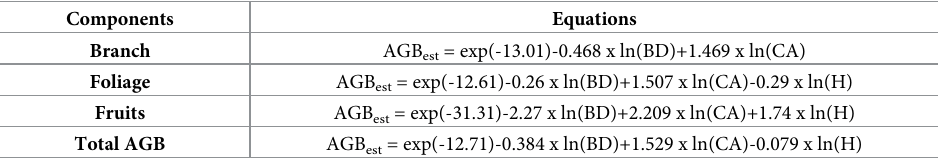
Table 4. The best-fitting equations for components and total AGB of Nitraria sibirica